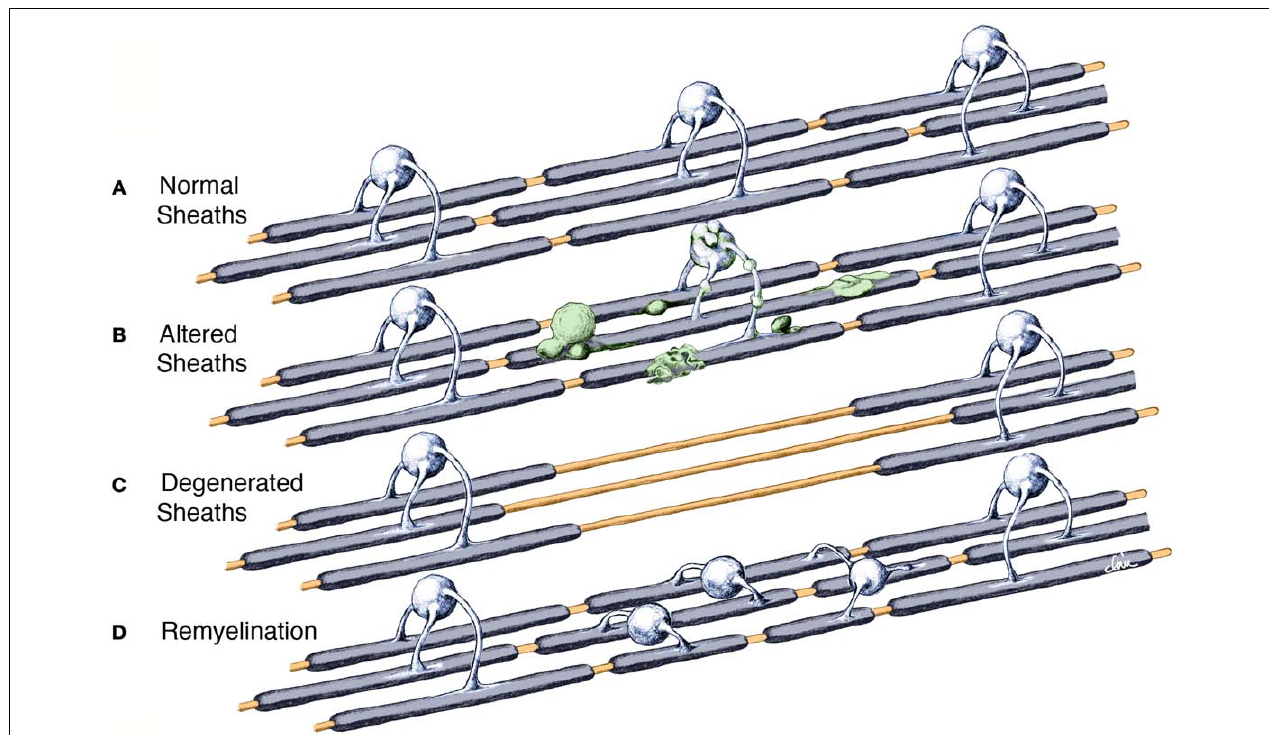
FIGURE 5 | Diagrammatic representation of the degeneration of sheaths with age, and the subsequent remyelination of axons. (A) Normal state. (B) Some sheaths become altered by the presence of dense cytoplasm and the formation of balloons. This is believed to occur when the oligodendrocyte